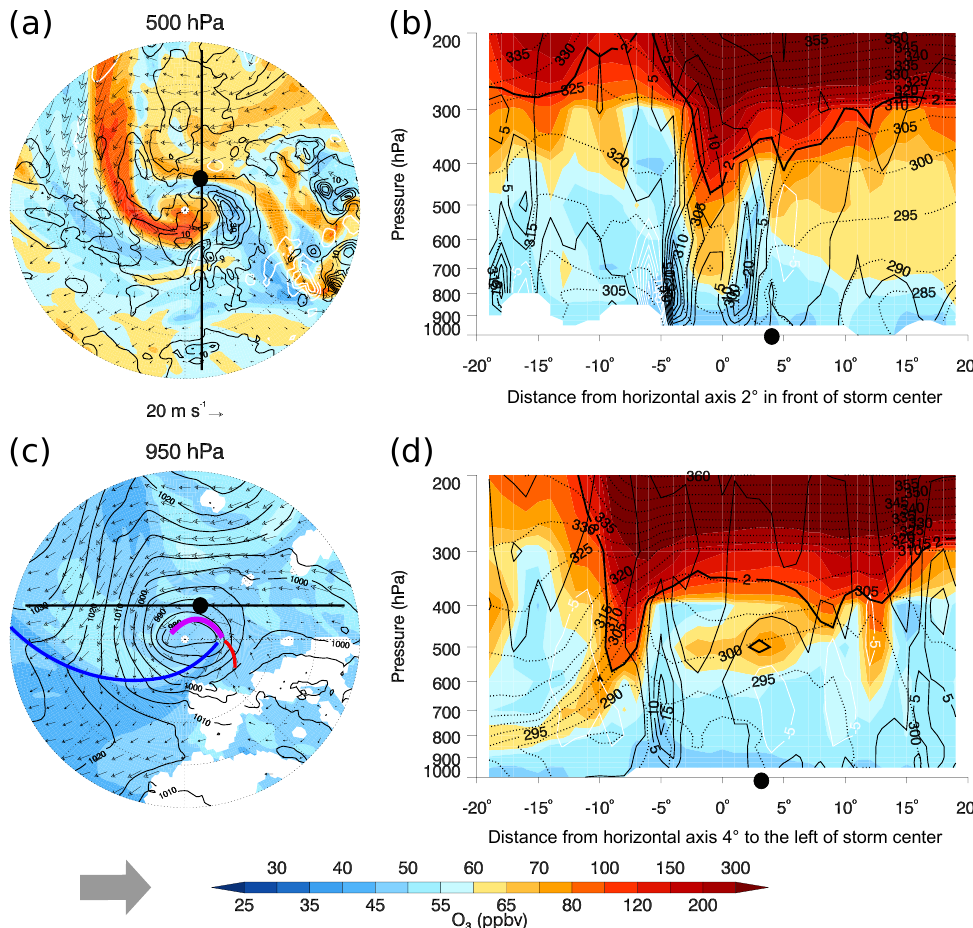
Figure 11. S1 cyclone on 25 April 2012 at 00:00UTC, similar to Fig. 10 except using MERRA-2 reanalysis data. Note: (c) is 950hPa instead of 1000hPa to minimize the missing data plotted. This occurs since the GEOS-5 model masks